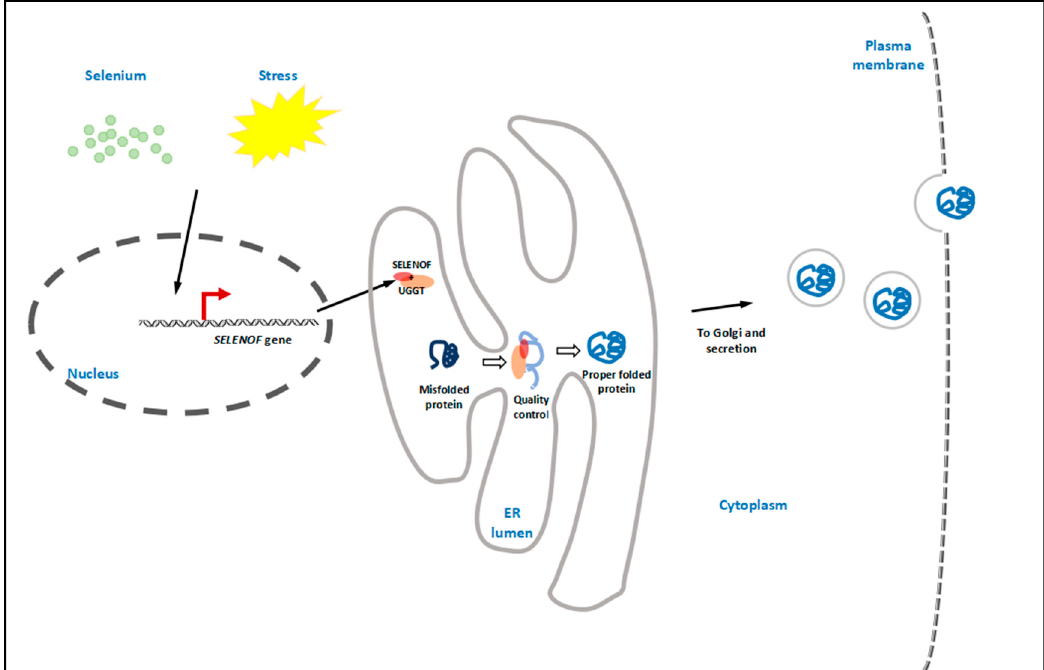
Figure 1. Graphical conclusion. As an endoplasmic reticulum (ER) selenoprotein, SELENOF can be regulated by both selenium status and ER stress. It forms a 1:1 tight complex with UDP-glucose:glycoprotein glucosyltransferase (UGGT) in the ER lumen, thus enhancing the enzymatic activity of UGGT. SELENOF may be involved in glycoprotein folding quality control by rearranging